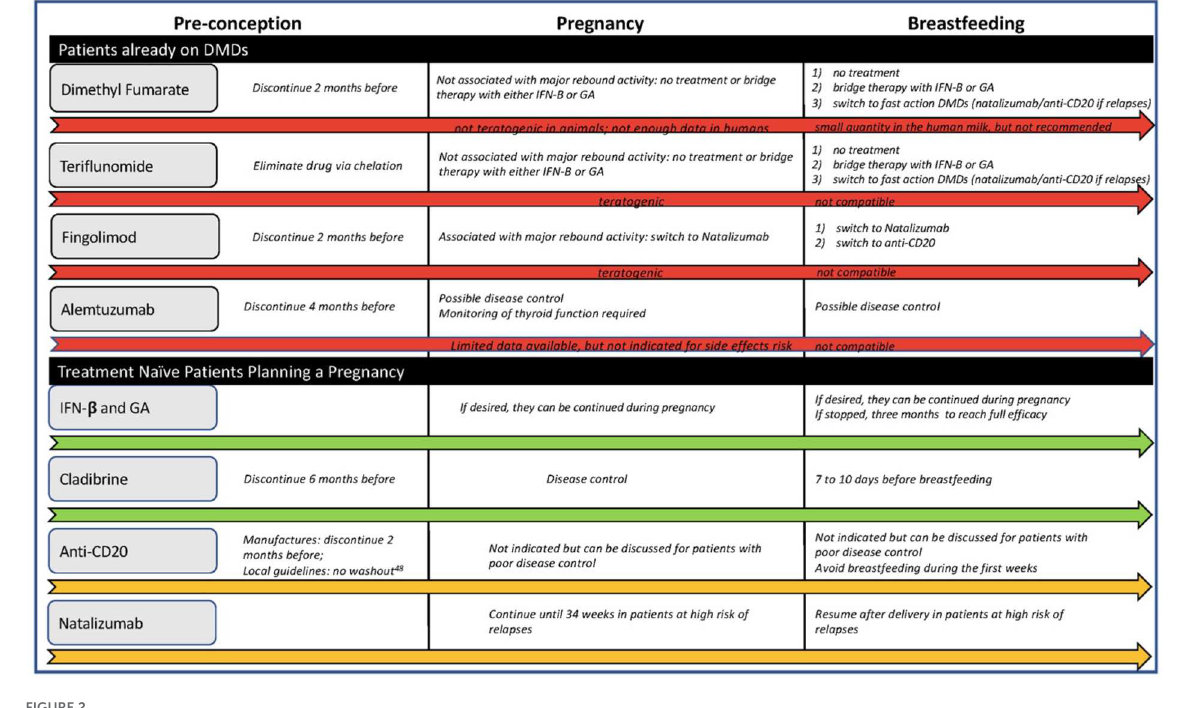
FIGURE2 Treatment flowchart. IFN, interferon; GA, glatiramer